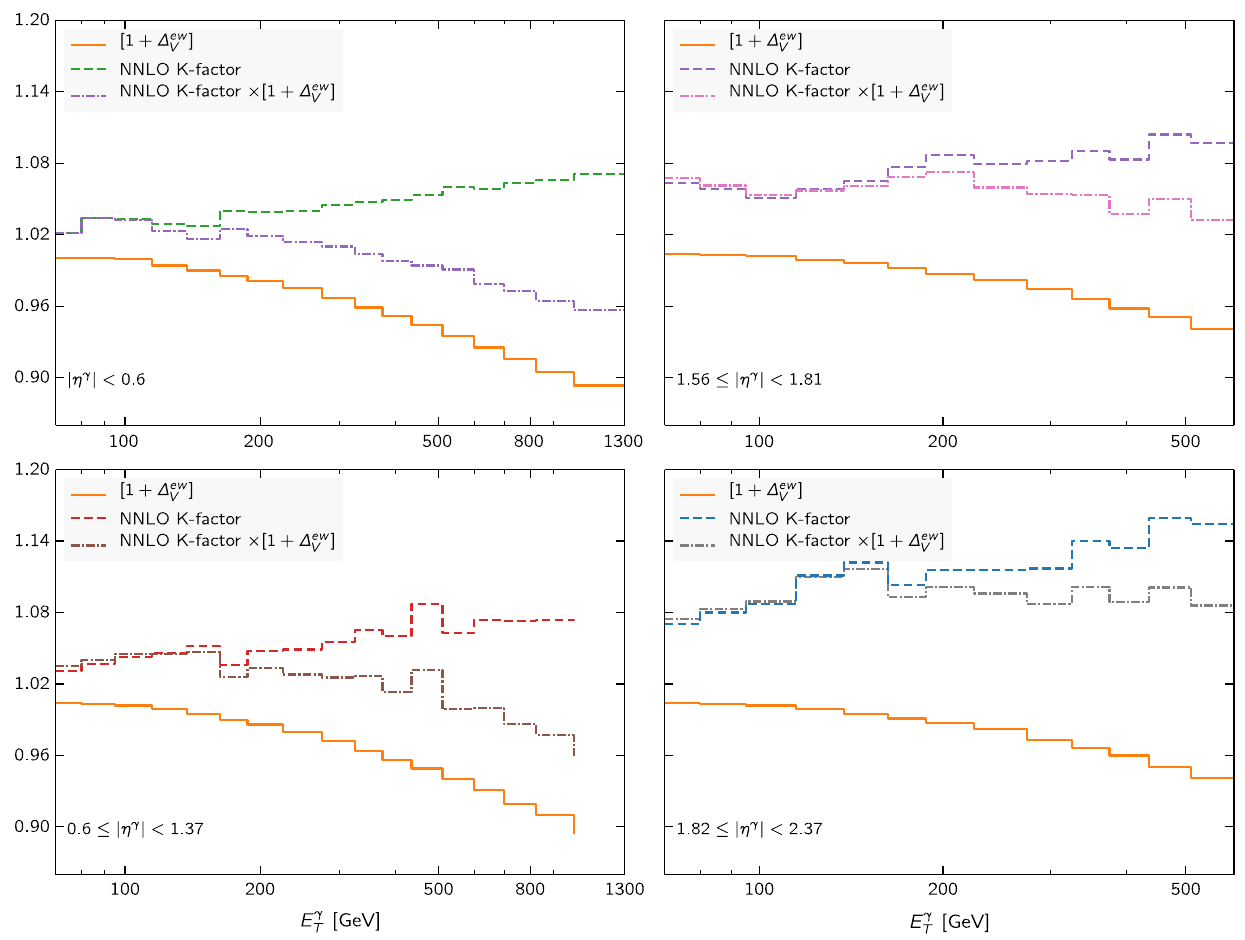
( E γ , s ) ] , Eq. (3.4), in the four rapidity bins of the ATLAS T V